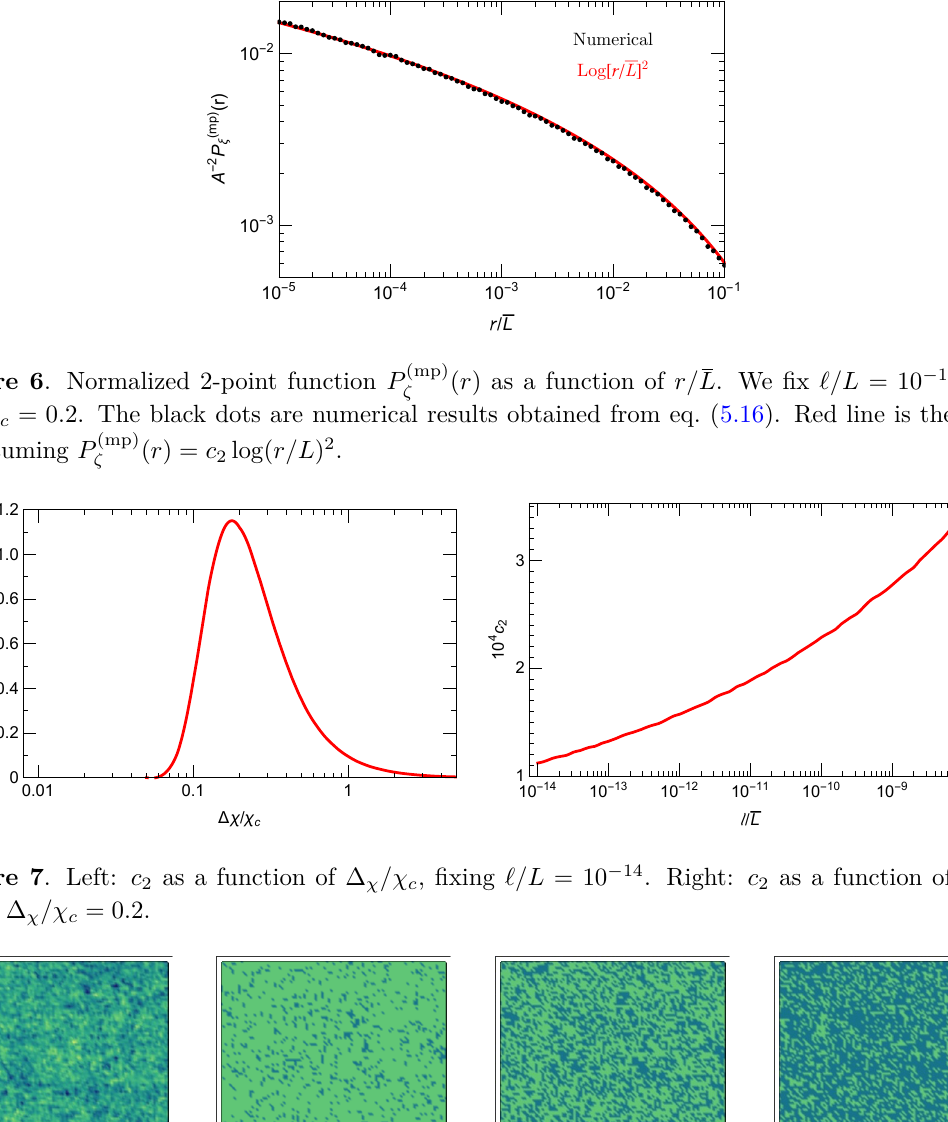
we vary ‘/L by several orders of magnitude, c proves that c only depends logarithmically on ‘/L 2